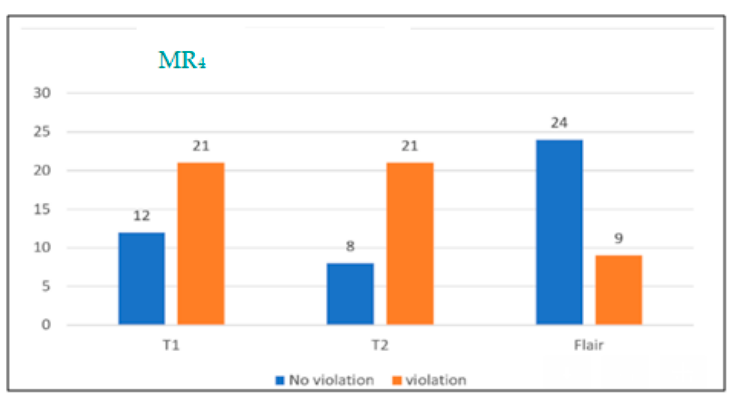
Figure 10. No. of test cases violating MR 4 on T1, T2, and flair images.